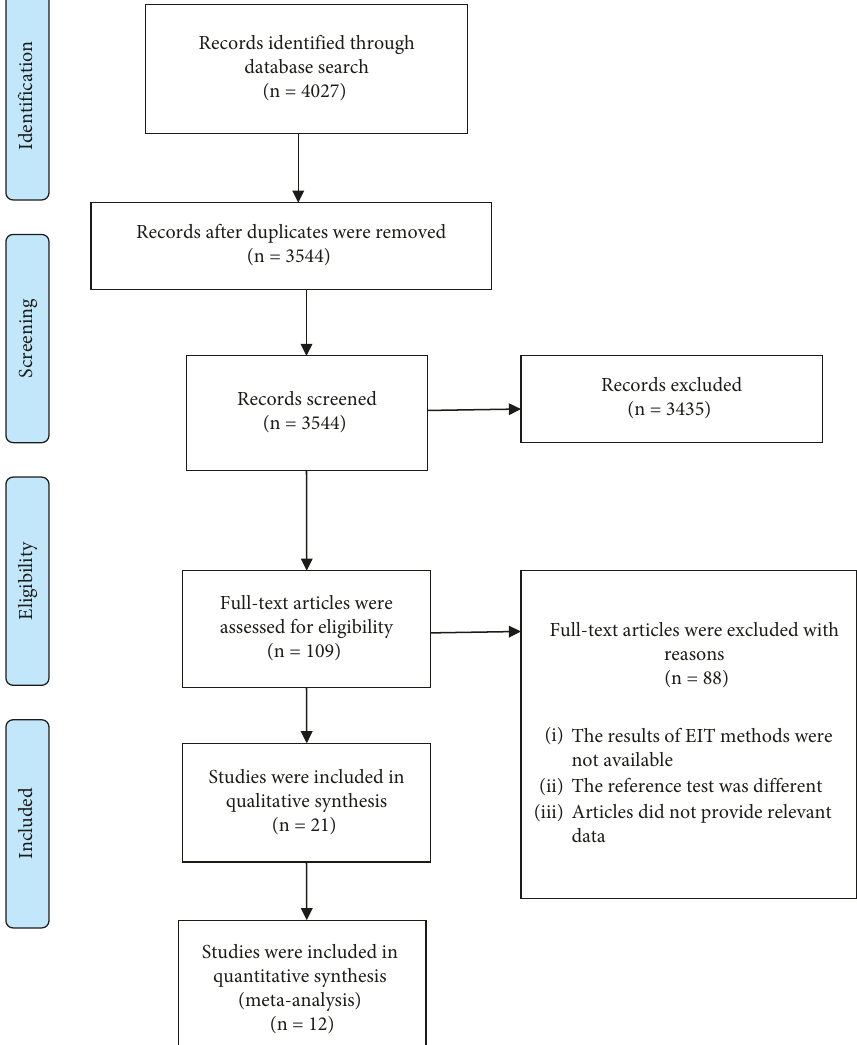
Figure 1: The flowchart illustrating the article search process and study inclusion.